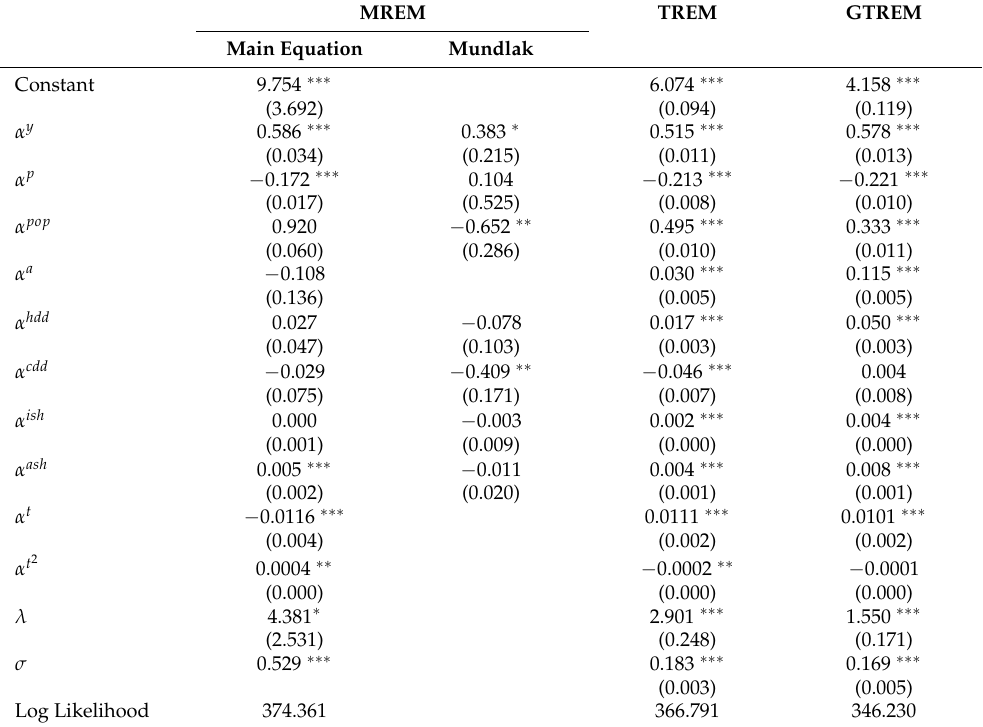
Table 5. Estimation